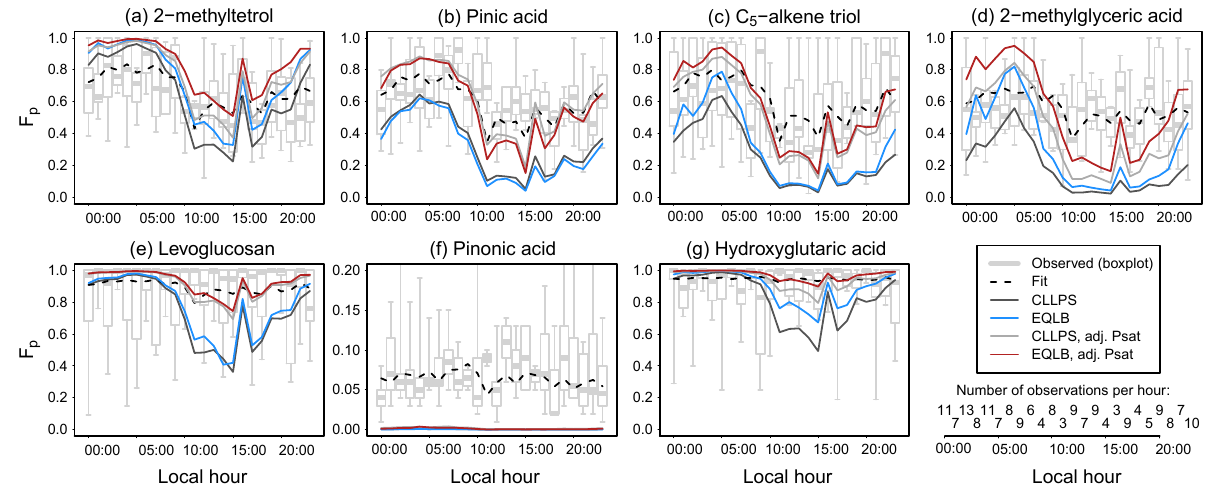
Figure 6. Fraction of each explicit organic species in the particle as a function of hour of day between 1 June and 15 July 2013 at CTR. The 2-methyltetrols were modeled as 50% dimers in the particle for CLLPS and EQLB. When the pure-species vapor pressure was adjusted, 2-methyltetrols were assumed to be entirely monomers. Fit is based on traditional absorptive partitioning to an organic-compounds-only phase (Eq.